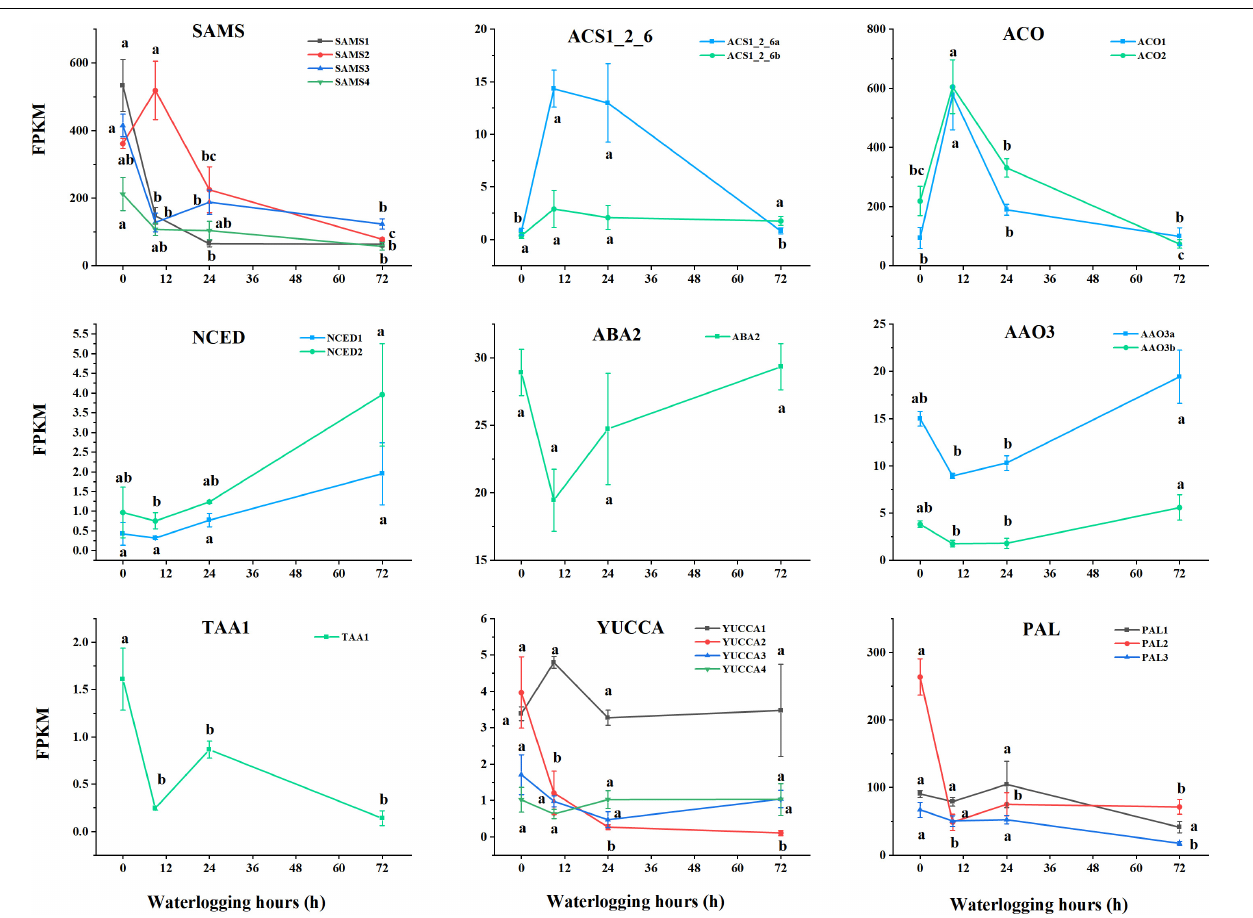
FIGURE 6 | Dynamic patterns of related unigenes and transcription factors in phytohormones biosynthesis (ET, ABA, IAA, and SA). Data are means ± SD of three biological replicates. Abbreviations: ET: SAMS, S -adenosylmethionine synthetase [EC:2.5.1.6]; ACS1_2_6, 1-aminocyclopropane-1-carboxylate synthase 1/2/6 [EC:4.4.1.14]; ACO, aminocyclopropanecarboxylate oxidase [EC:1.14.17.4]; ABA: NCED, 9-cis-epoxycarotenoid dioxygenase [EC:1.13.11.51]; ABA2, xanthoxin dehydrogenase [EC:1.1.1.288]; AAO3, abscisic-aldehyde oxidase [EC:1.2.3.14]; IAA: TAA1, L-tryptophan—pyruvate aminotransferase [EC:2.6.1.99]; YUCCA, indole-3-pyruvate monooxygenase [EC:1.14.13.168]; SA: PAL, phenylalanine ammonia-lyase